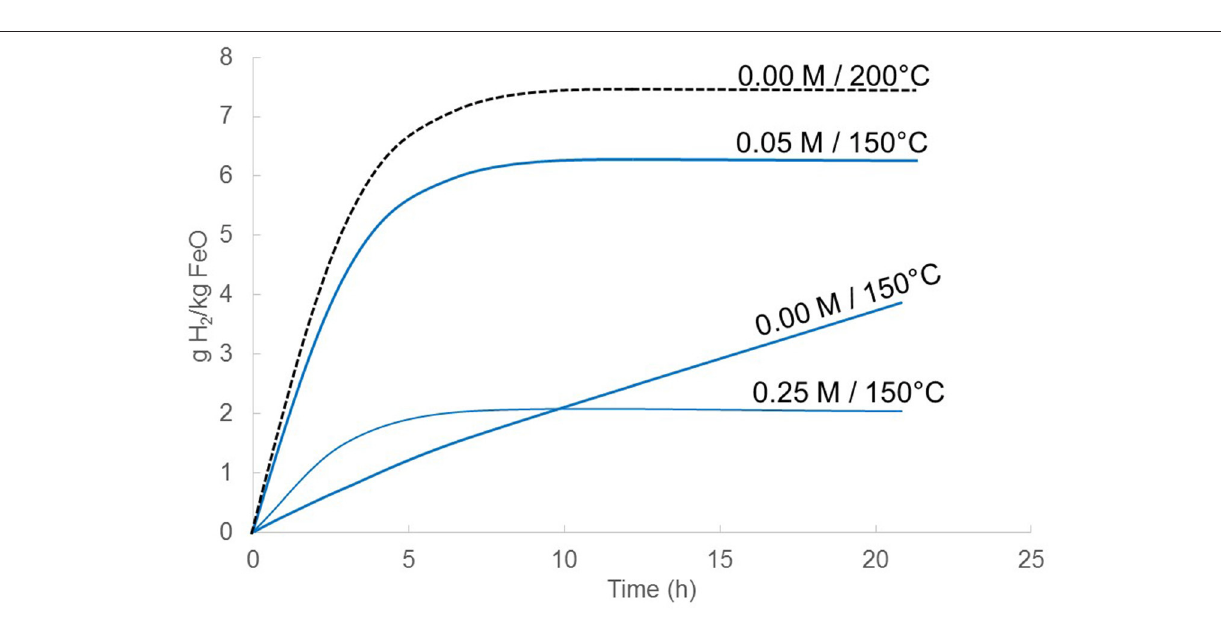
FIGURE 4 | Effect of temperature and acid acetic concentration on H 2 production kinetics and yield. The H 2 yield (g/kg FeO) is modeled for a solid-to-solution mass ratio of 1:200. For the calculation, initial water volume is fixed to 200mL, corresponding to a headspace of 300mL. Temperature is 150 ◦ C and 200 ◦ C, pressure is 15 MPa. Higher solid-to-solution mass ratio implies a lesser proportion of the initial FeO that is dissolved; accordingly, the H 2 yield is higher. The H 2 yield is modeled for acid acetic concentrations of 0, 0.05, and 0.25M. Note that the highest concentration (0.25M) produces less H 2 since a larger proportion of Fe resides in the solution and does not produce